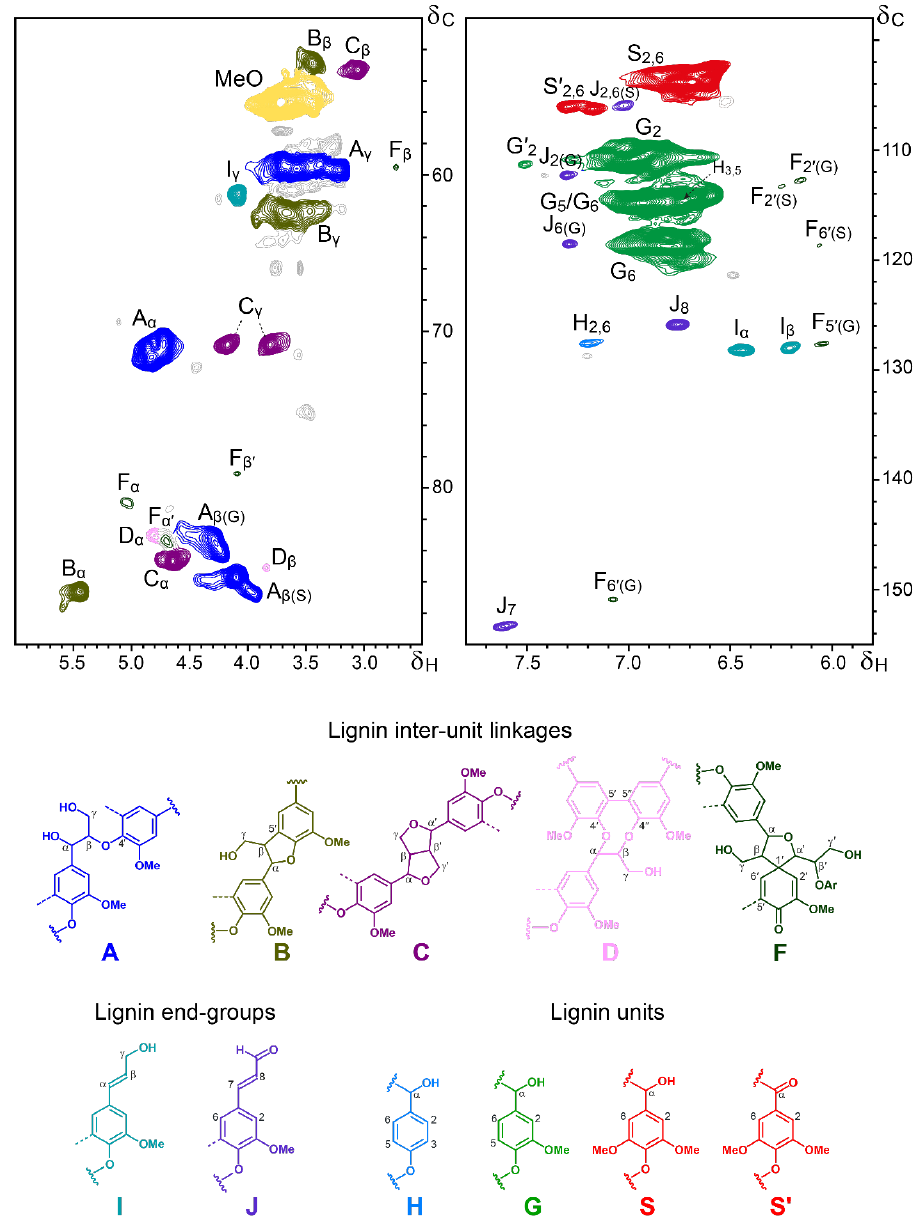
Figure 2. Sidechain ( δ C / δ H 50–90/2.5–6.0; left) and aromatic ( δ C / δ H 98–155/5.8–7.8; right) regions of the HSQC spectrum (in DMSO- d 6 ) of the OTP-MWL. The lignin structures identified are shown below: A : β– O –4′ alkyl– aryl ethers; B : phenylcoumarans; C : resinols; D : dibenzodioxocins; F : spirodienones; I : p -hydroxycinnamyl alcohol end-groups; J : p -hydroxycinnamaldehyde end-groups; H : p -hydroxyphenyl units; G : guaiacyl units; S : syringyl units; S ′ : α -oxidized syringyl units.